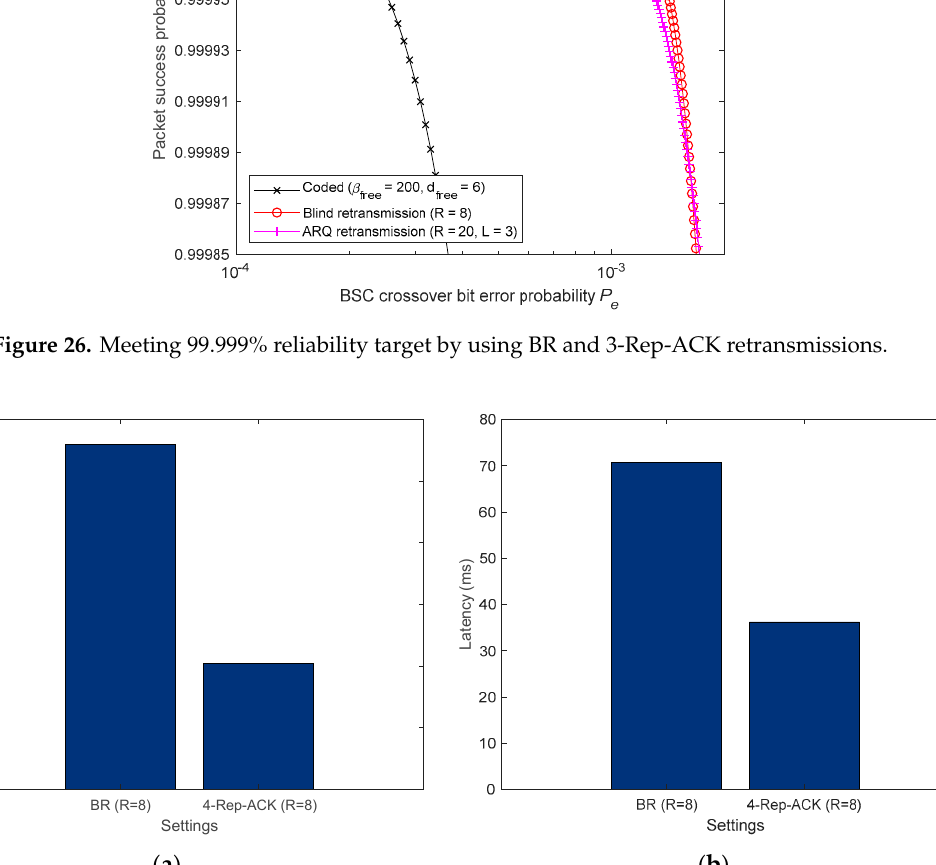
Figure 27. ( a ) Energy consumption per measurement and ( b ) system latency for a 99.999% reliability.